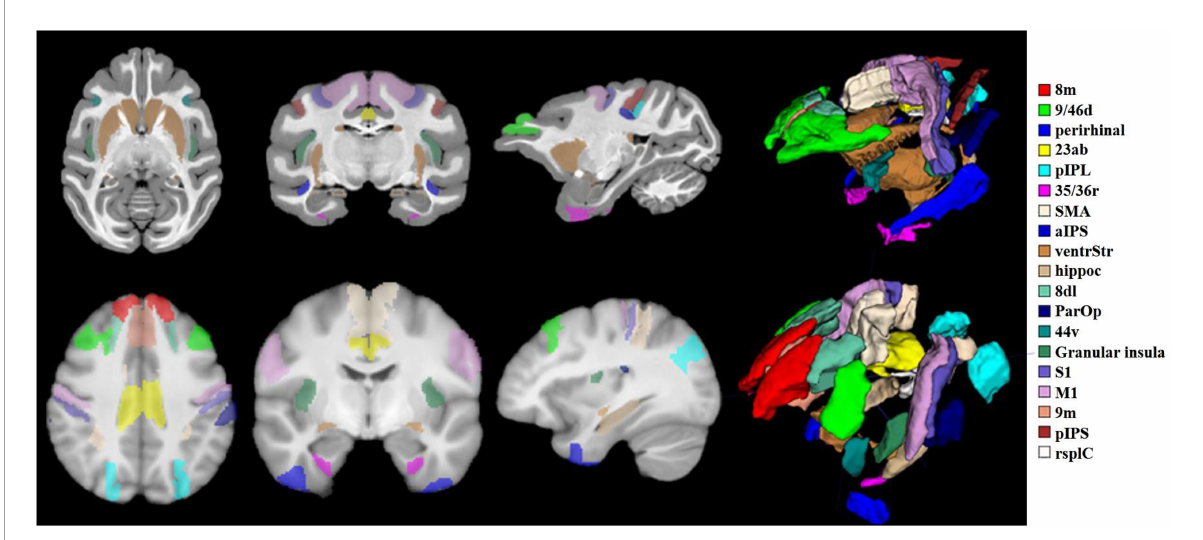
FIGURE2 Schematic of 19 target ROIs in the human and macaque brains. The schematic diagram shows the spatial locations of the 19 ROIs selected in this paper under the macaque D99 atlas and the human brainnetome atlas. The relevant regions of interest are marked with 19 different colors, and the relationship between the color and the region is displayed on the far right of the picture. To display the 19 ROIs more intuitively, a 3D stereo image is drawn on the right side of the brain